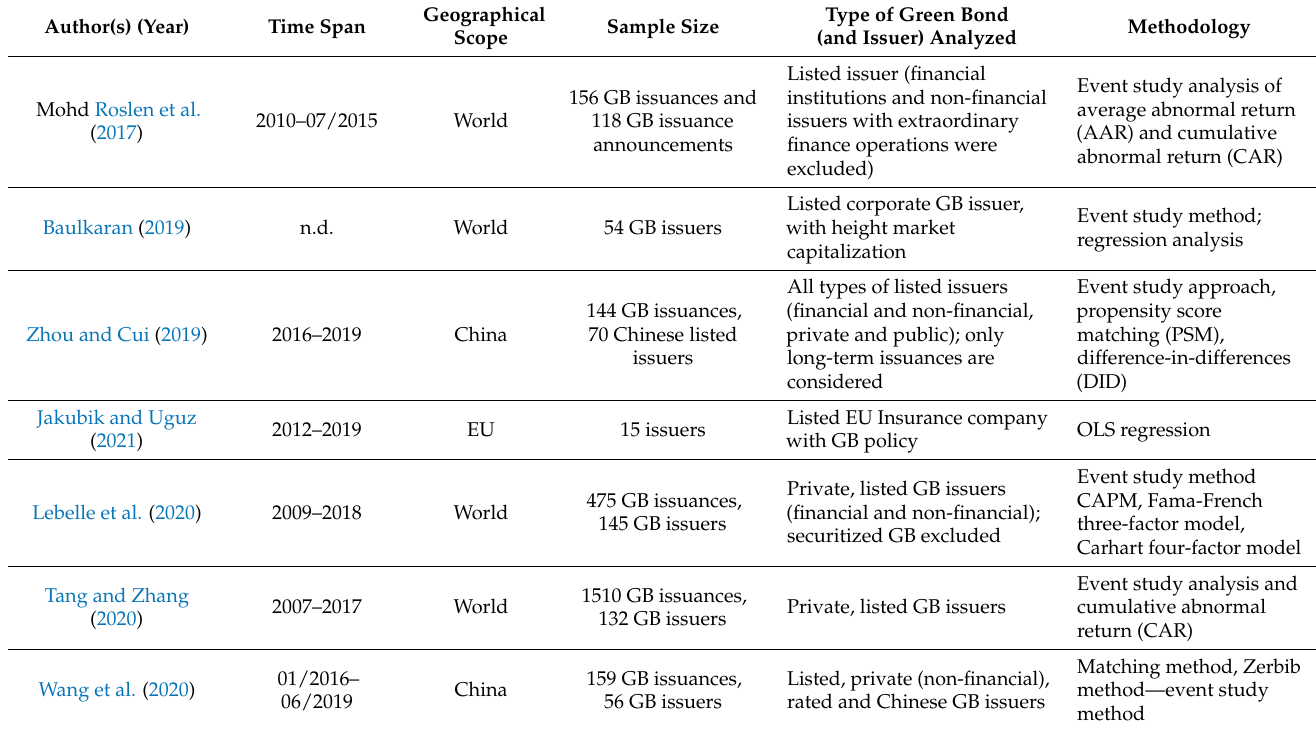
Table 7. “Green bond and stock reaction” empirical literature by the type of sample and